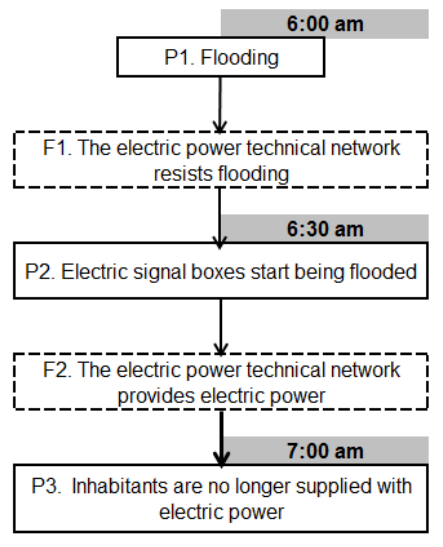
Figure 4. Sample of a directed graph dynamic causal model appli- cation, for the electric power technical